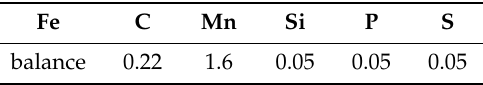
Table 1. Chemical composition of S235 steel in wt.%.